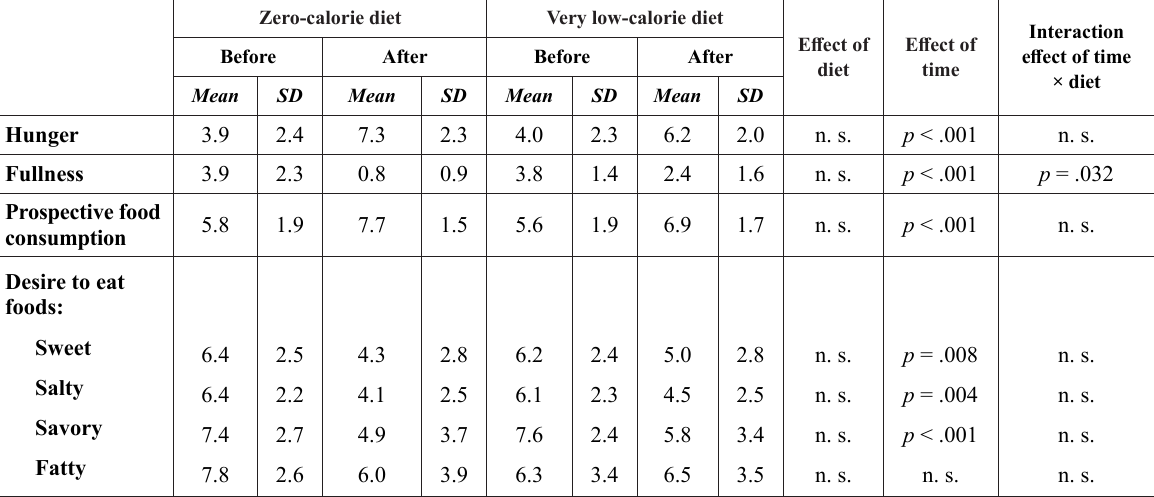
= 0.24). = 0.24). �� Mood states. The mood states of the participants are reported in Table 3. The significant ŋ = 0.24). �� ŋ �� ŋ = 0.24). �� ŋ Inhibitory control. Data of inhibitory control requiring tasks are reported in Table 4. There was no significant effect of time and diet, or the time × diet interaction on the inhibitory control.